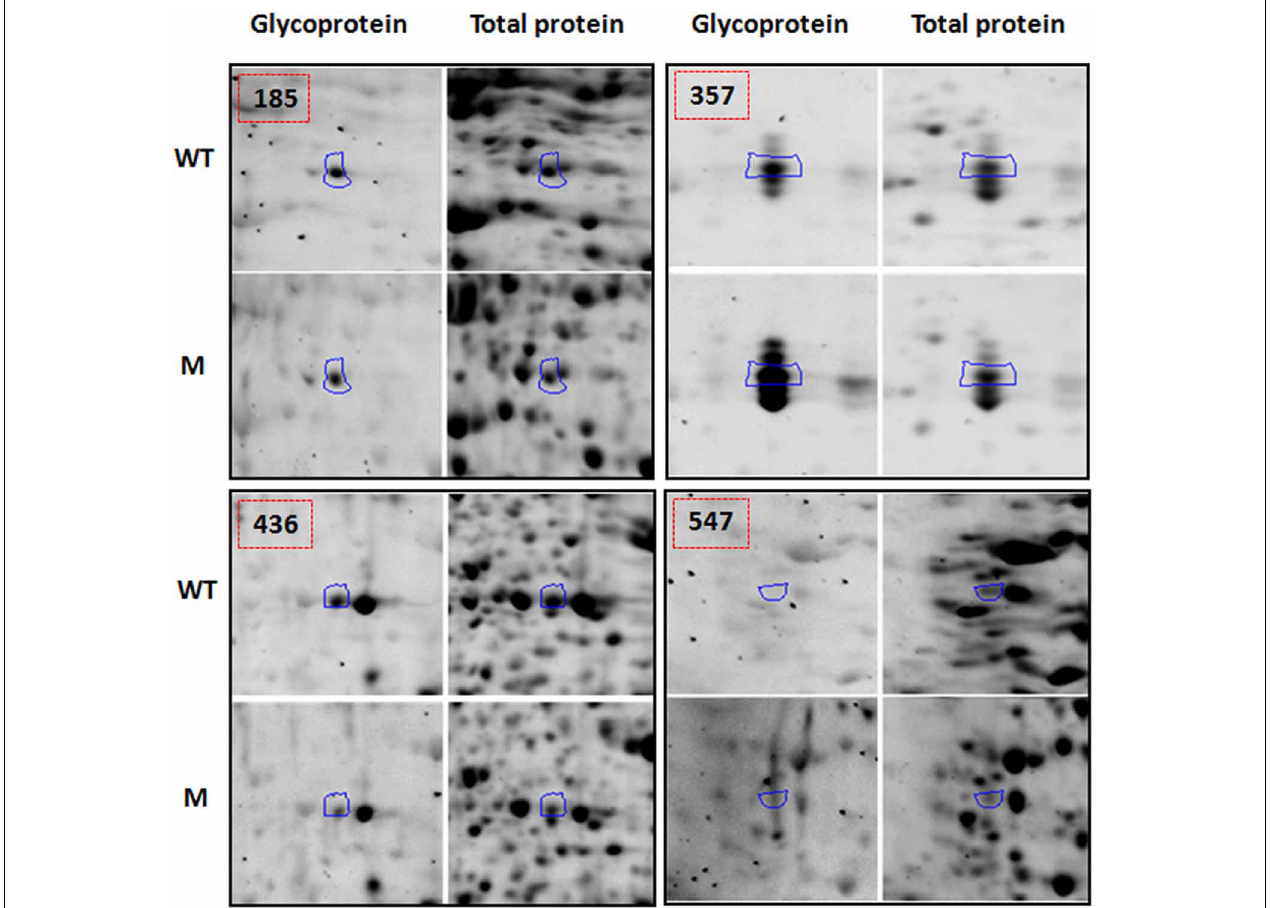
FIGURE 2 | Examples of protein spots from BETL total protein extracts [spot 185 [ M ( G / TP ) / WT ( G / TP ) = 0 . 97], spot 357 [ M ( G / TP ) / WT ( G / TP ) = 0 . 74], spot 436 [ M ( G / TP ) / WT ( G / TP ) = 0 . 69], and spot 547 [ M ( G / TP ) / WT ( G / TP ) = 2 . 35] showing quantitative differences in glycosylation (G) and total protein (TP) between WT and mutant after glycoprotein and